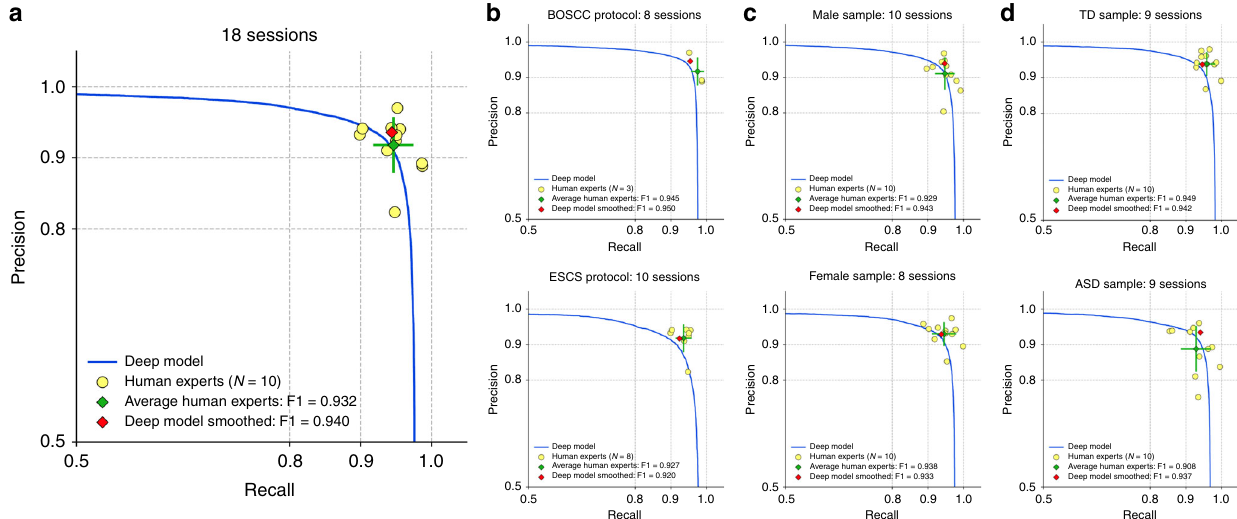
Fig. 2 Precision and recall (PR) of deep learning model and human raters. The blue line is the PR curve for the model, zoomed into the range 0.5 – 1.0. Human rater data are presented as mean values ± SD. Improved model PR (red diamond) is obtained by temporally smoothing the model output. The PR for each of the ten expert raters (yellow dots) is obtained by comparing an expert's ratings to the consensus ratings of the other nine experts. a PR curve on all 18 validation sessions. The model (red diamond) achieves higher precision than the average of the expert raters (green diamond) for the same recall. The model PR (red diamond) lies within one standard deviation (green error bars) of the mean rater, and both the model and the mean rater have similar F1 scores. Therefore, we conclude that the deep learning model exhibits comparable performance to expert human raters. b PR curves computed separately for the BOSCC (top) and the ESCS protocol (bottom). c PR curves computed separately for male (top) and female (bottom) samples. d PR curves computed separately for TD (top) and ASD (bottom) samples. In all cases, model PR lies within one SD of the mean